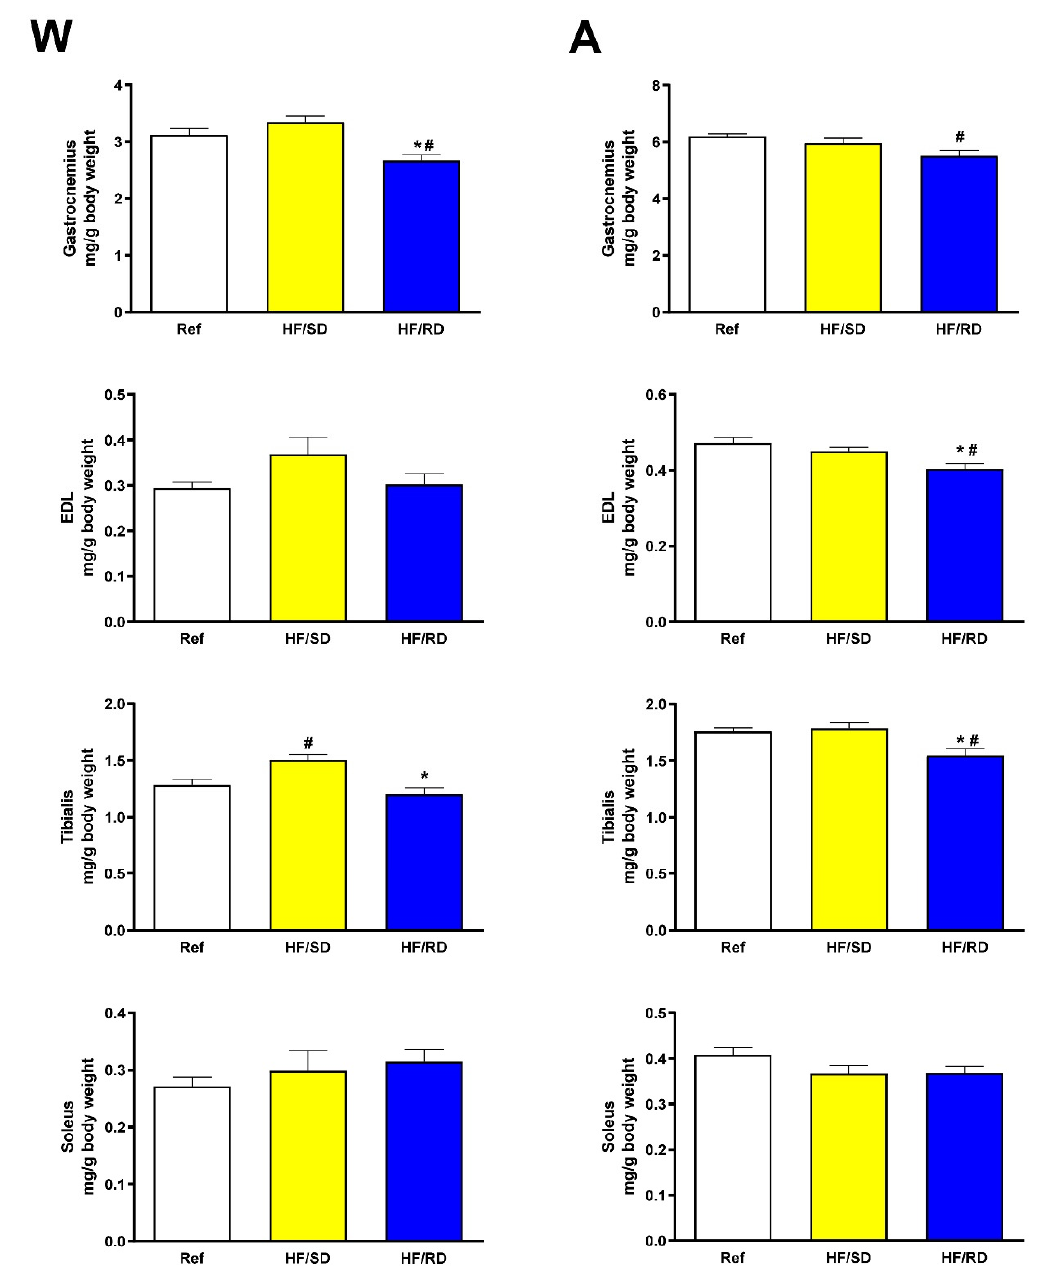
Figure 1. Muscle weight in the offspring. The muscle weight referenced to total animal weight were measured at weaning ( W ) and adolescence ( A ). Values are means ± standard error of the mean (SEM) (n = 8 for each experimental group). HF/SD: offspring from mothers on high-fat diet containing slow digesting carbohydrates; HF/RD: offspring from mothers on high-fat diet containing rapid digesting carbohydrates; Ref: offspring from mothers on AIN93G diet. * Significant difference with HF/SD group, p < 0.05. # Significant difference with reference group, p < 0.05. EDL: extensor digitorium longus.